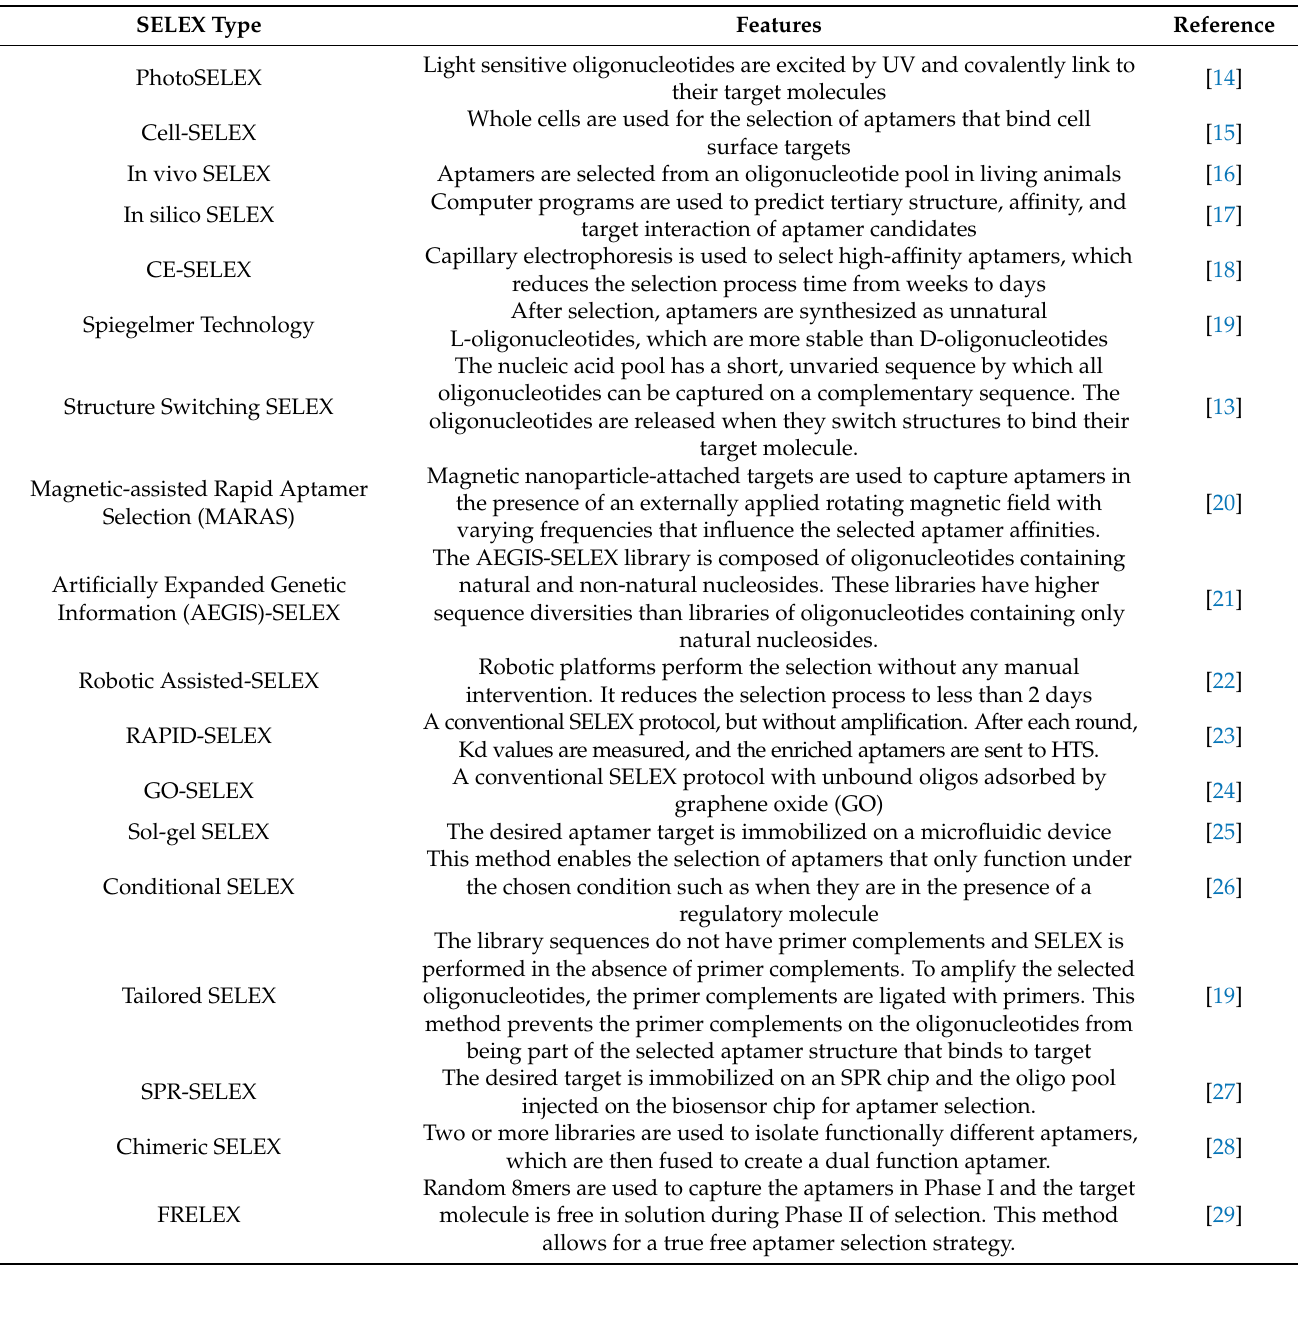
Table 1. Summary of Alternative SELEX